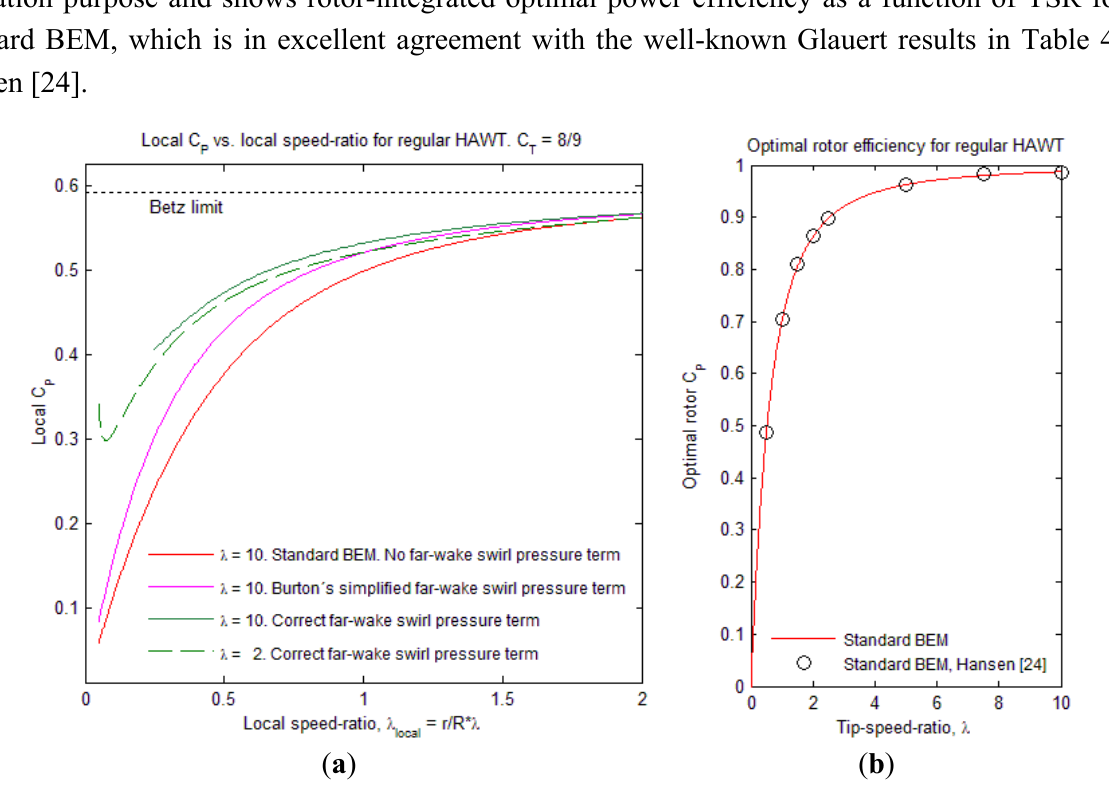
Figure 3. ( a ) Local power efficiency versus local speed-ratio at a tip-speed ratio (TSR) of 10 for three different treatments of the far-wake pressure term. Note that only the local speed-ratio matters for the two blade-element momentum (BEM) versions with tube element independency (Standard BEM, BEM with simplified far-wake pressure term). Tube element independency is sacrificed in the present BEM with correct far-wake pressure term. This is why the local C p changes slightly when the TSR is reduced from 10 to 2 (green curves); ( b ) Comparison of standard BEM results for optimal rotor C p with ref.